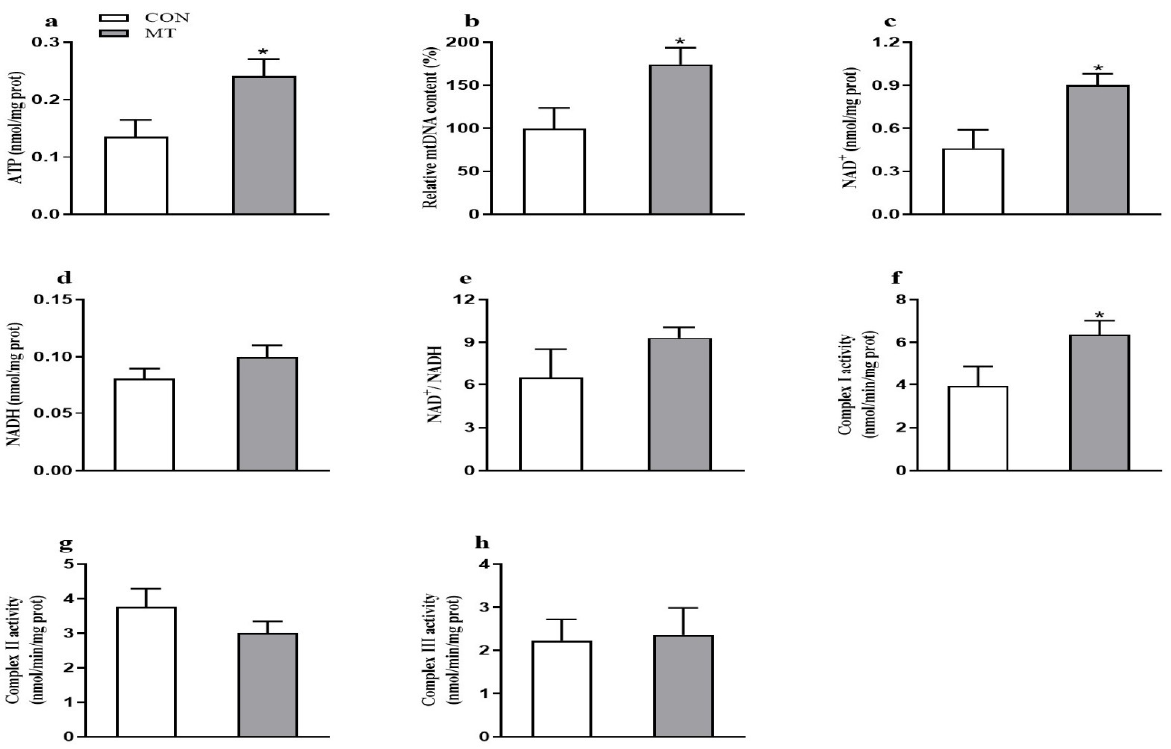
Figure 5. Effects of maternal MT supplementation during gestation on mitochondrial function in the placenta. ( a ) ATP levels. ( b ) Mitochondrial DNA (mtDNA) copy number. ( c ) NAD + . ( d ) NADH. ( e ) The ratio of NAD + /NADH. ( f ) Complex I activity. ( g ) Complex II activity. ( h ) Complex III activity. Data are presented as means ± SEM, n = 8. * p < 0.05. CON = control, MT = melatonin.